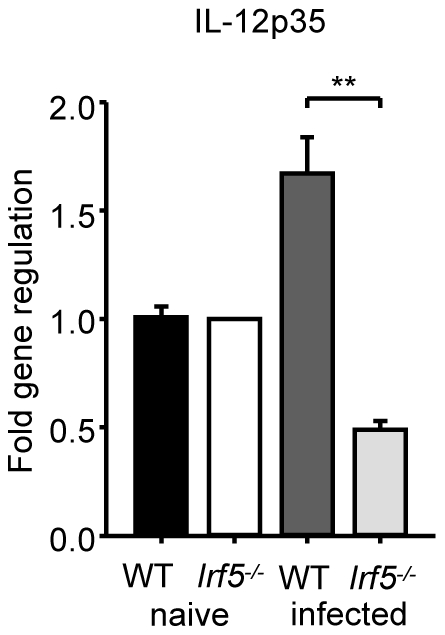

L. donovani fails to induce IL-12p35 expression in Irf5-/- mice.WT and Irf5
-/- mice were infected with L. donovani amistigotes. At 5 h, splenic cDCs were purified. IL-12p35 mRNA was detected by real time PCR. Data is shown for n = 3 WT samples and n = 4 Irf5
-/- samples.* denotes p<0.05 and ** denotes p<0.01.